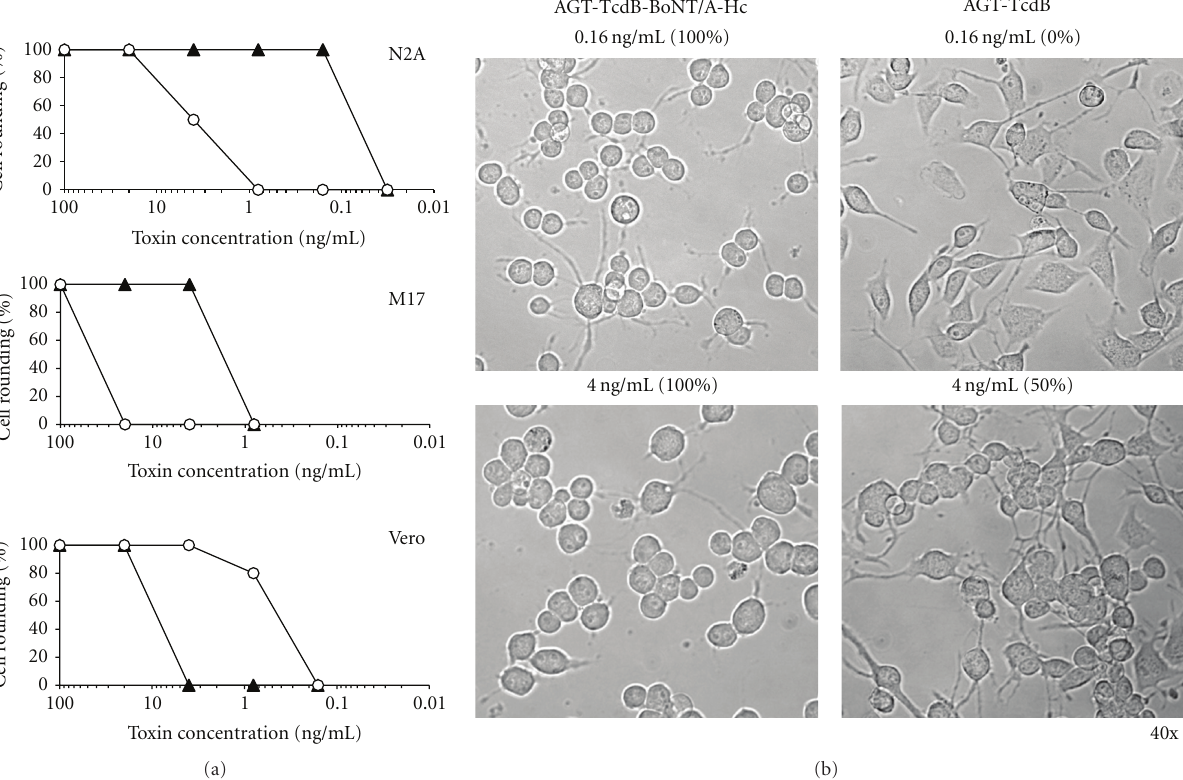
Figure 5: A TcdB chimera with the BoNT/A receptor-binding domain has increased specificity for neuronal cells. (a) Toxin potency of AGT- TcdB and AGT-TcdB-BoNT/A-Hc on two neuronal cell lines and Vero cells. Potency was assessed by serial dilutions of purified recombinant AGT-TcdB-BoNT/A-Hc ( (cid:2) ) and AGT-TcdB ( ◦ ). The potency was determined on Neuro2A and M17 neuroblastoma cells and Vero cells. Fivefold serial dilutions of the proteins were added to medium, and cells were monitored for toxicity by assessing the % cell rounding after 24 hr. Data shown are representative of 4 independent experiments. (b) Microscopic images of Neuro2A cells exposed to AGT-TcdB or AGT-TcdB-BoNT/A-Hc. Representative images are shown of Neuro2A cells exposed for 24 hr to 0.16ng/mL or 4 ng/mL of either AGT- TcdB-BoNT/A-Hc or AGT-TcdB,